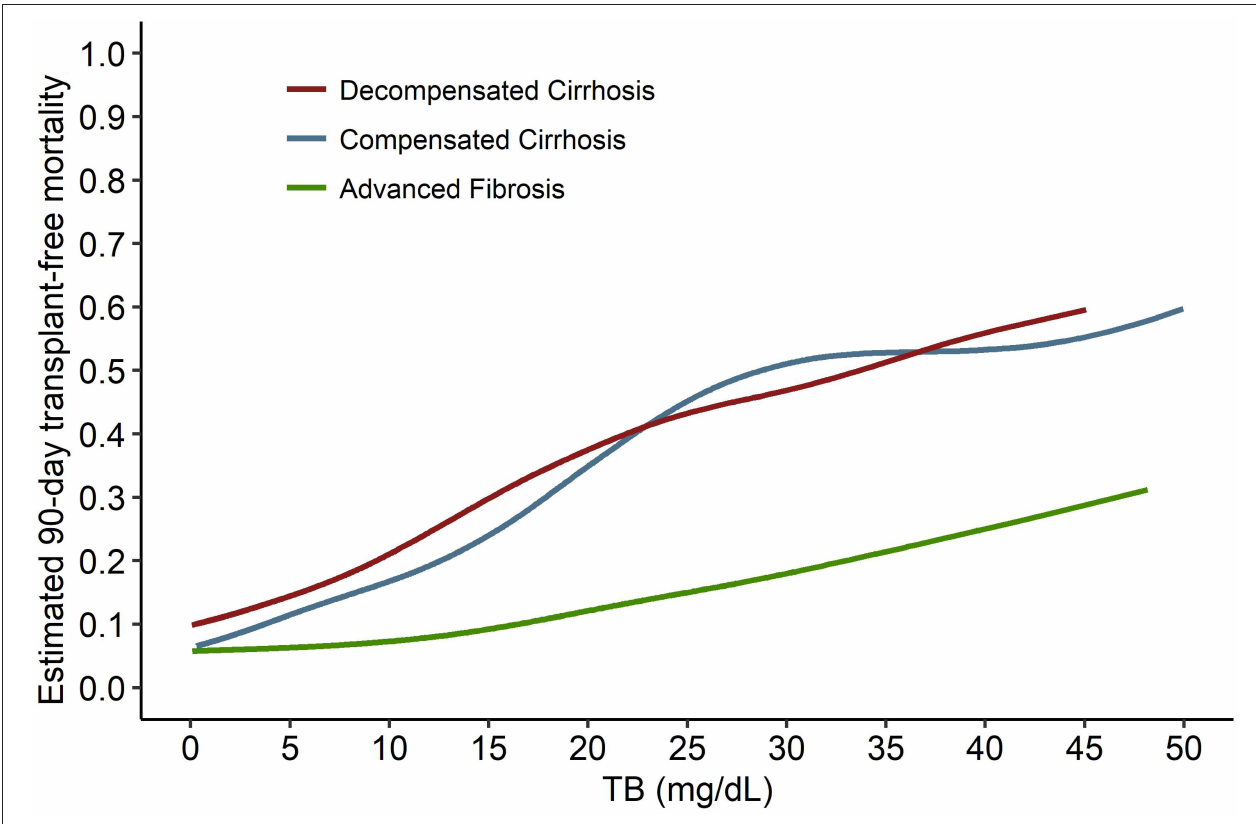
FIGURE 7 | The comparison of the TB-mortality curves between decompensated cirrhosis, compensated cirrhosis, and advanced fibrosis. TB, total bilirubin.